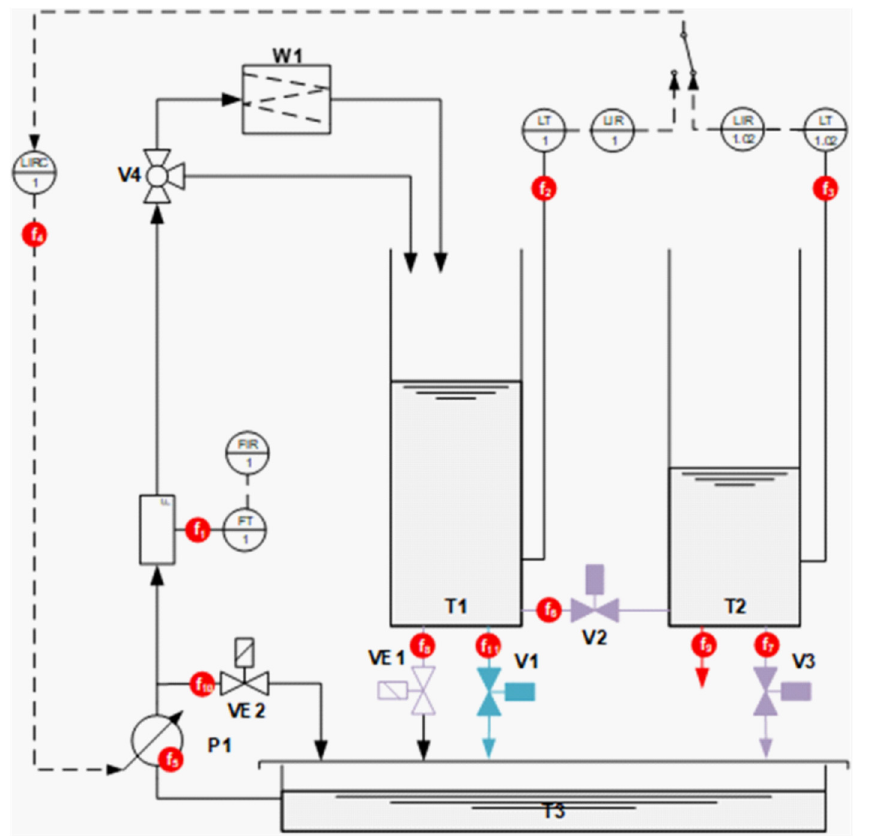
Figure 3. A schematic diagram of the laboratory test stand. Additionally, available measurements and the symbolic places of introduction of process faults are depicted. Table 1. Set of available process